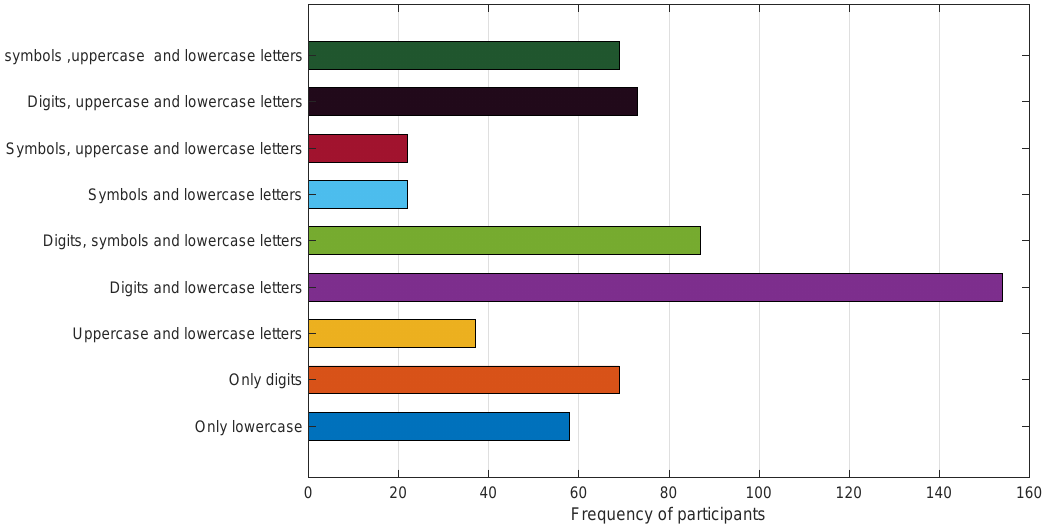
Figure 4. Character composition of the participants’ passwords